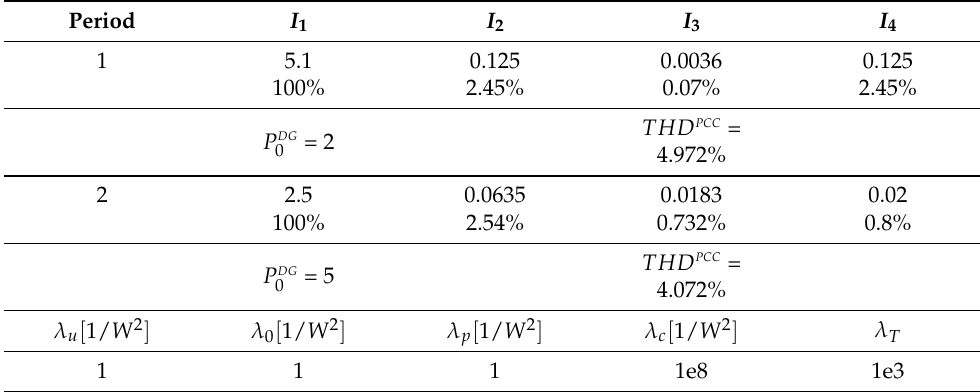
Table 4. Measured currents and weighting